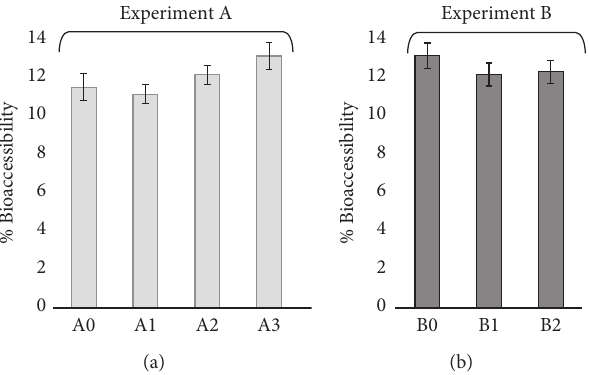
Figure 1: Total phenol content bioaccessibility after gastrointestinal in vitro digestion simulation of “Manzanilla” table olives of experiment A (a) ( ) and experiment B (b) ( ). Columns followed by the same letter within the same experiment were not significantly different ( p < 0 . 05), according to Tukey’s least significant difference